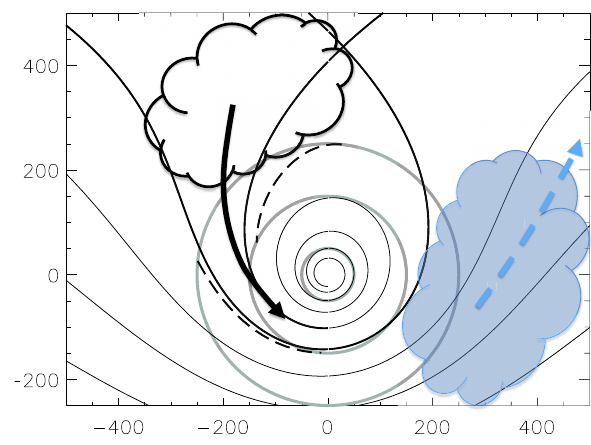
Figure 10. Same as Fig. 7(b), but for a Cat1 vortex in westerly storm-relative environmental flow of U = 5.1 ms − 1 . The dashed curves denote the envelope of streamlines for which environmental air reaches the ’rain band’ region in this scenario. The source region of air that interacts with the TC is indicated to the northwest. The area shaded in blue indicates a hypothetical region of very dry environmental air.